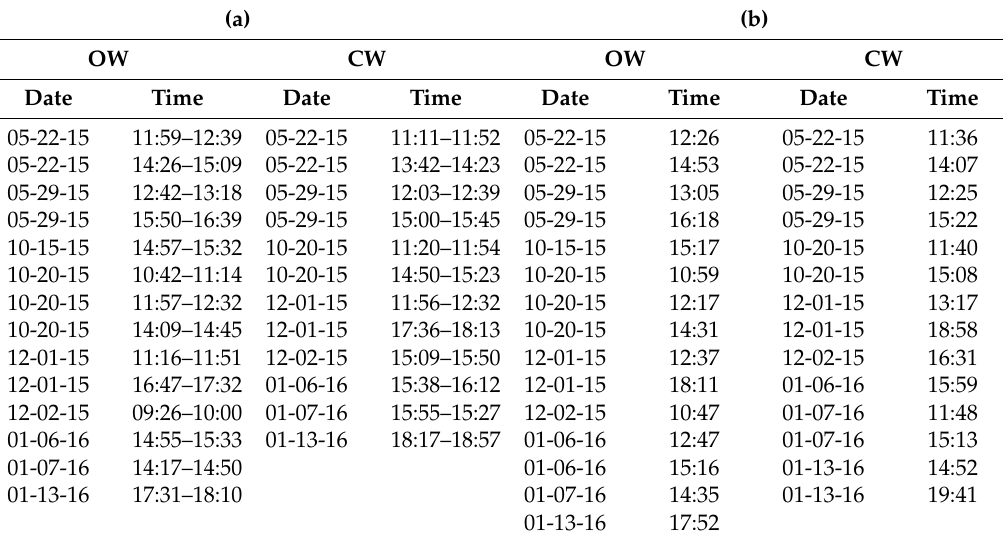
Figure 2. Course 1: Circular drive through Frankurt am Main passing the air quality monitoring stations (AQMS) “Friedberger Landstraße”. Red line: Driving route, yellow marks: Street names and places, green mark: Air quality monitoring station. Geographical picture by Google Earth. Table 1. Test rides on the circular drive through Frankfurt am